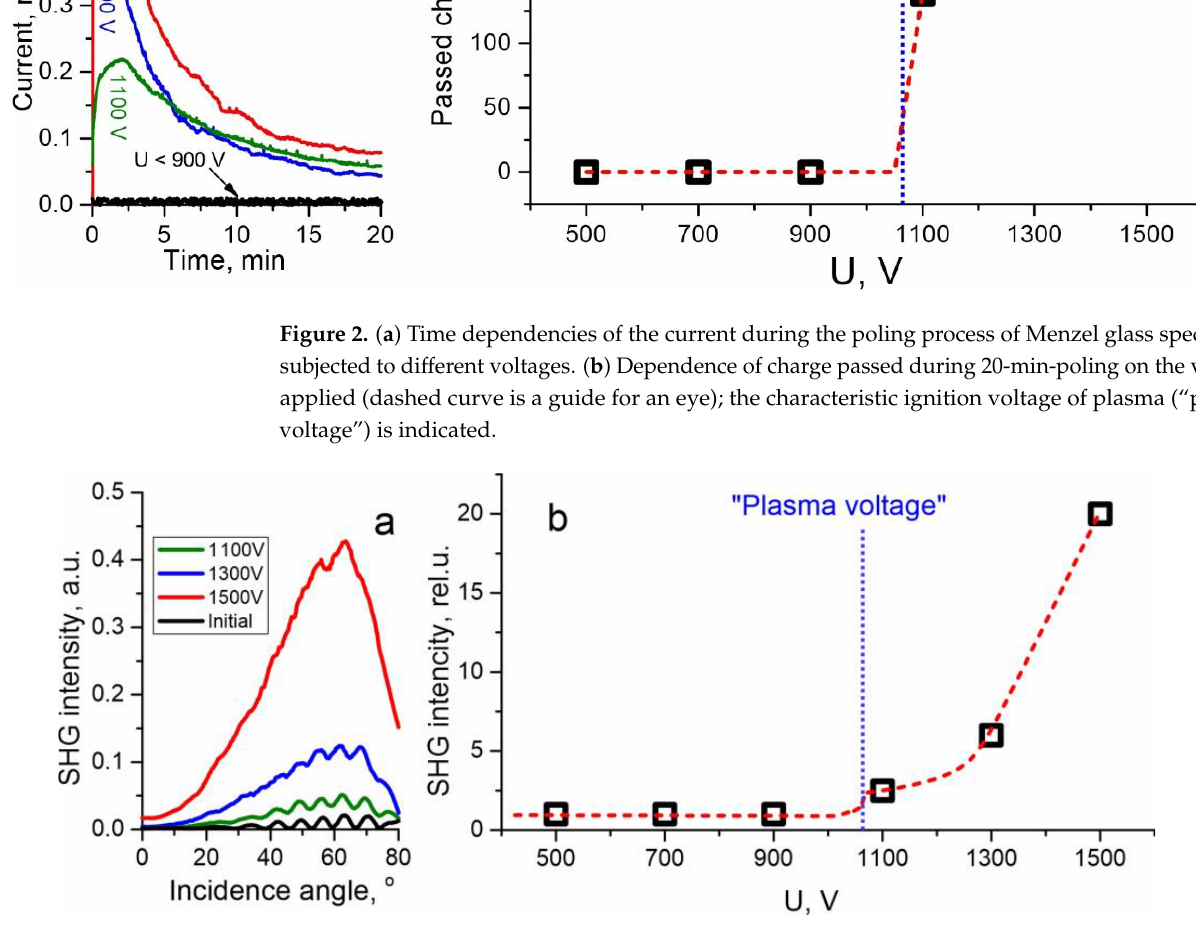
Figure 3. ( a ) Maker fringes for an initial glass (black) and for specimens subjected to 1100 V (olive), 1300 V (blue) and 1500 V (red). ( b ) Dependence of the maximal SH signal (at 63° incidence angle) on the voltage applied (dotted line is no more than guide for eyes); the dependence normalized by SH signal from the initial glass; ignition voltage of plasma is